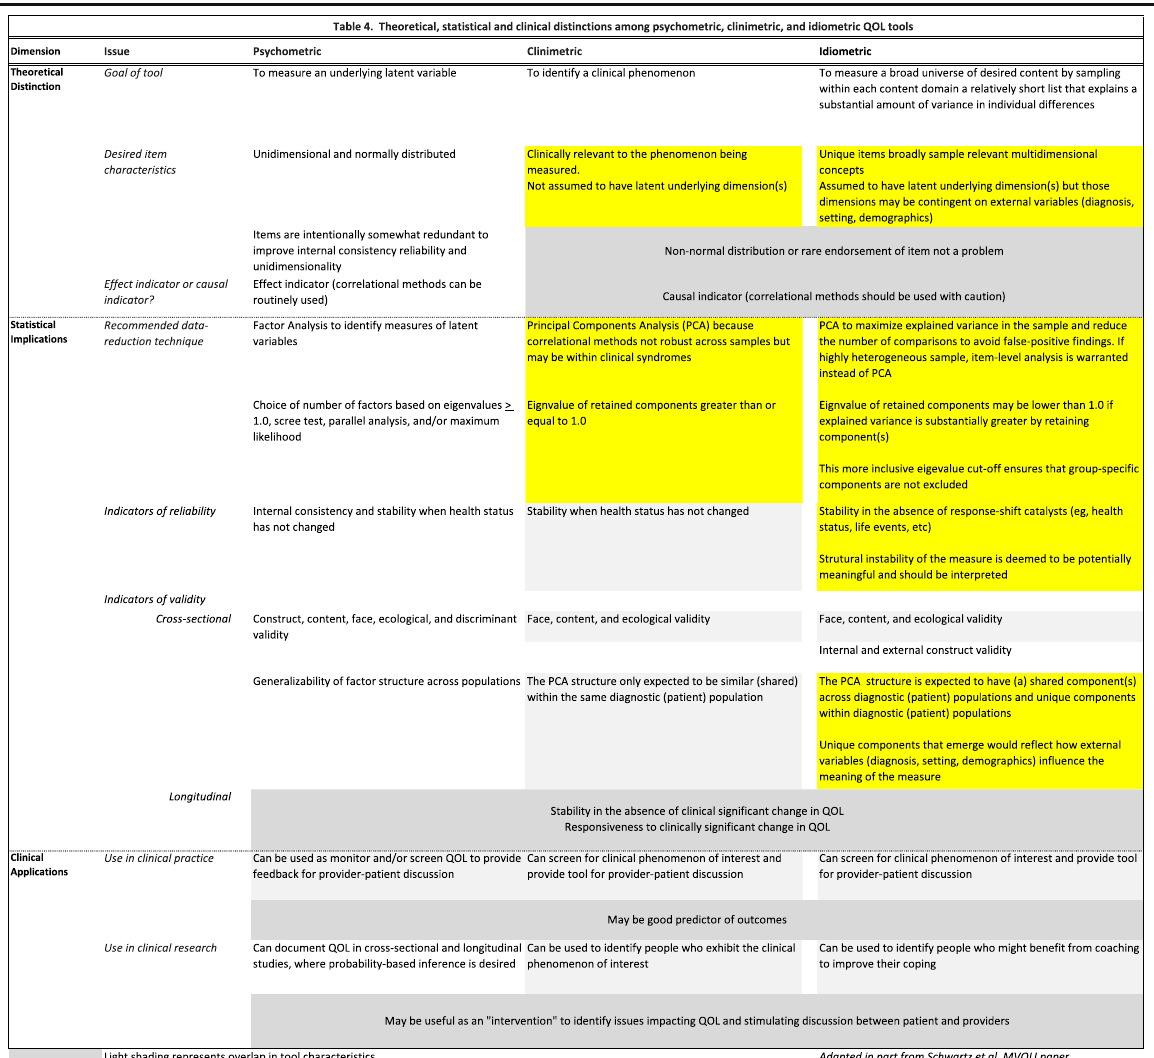
Table 4 Theoretical, statistical and clinical distinctions among psychometric, clinimetric, and idiometric QOL